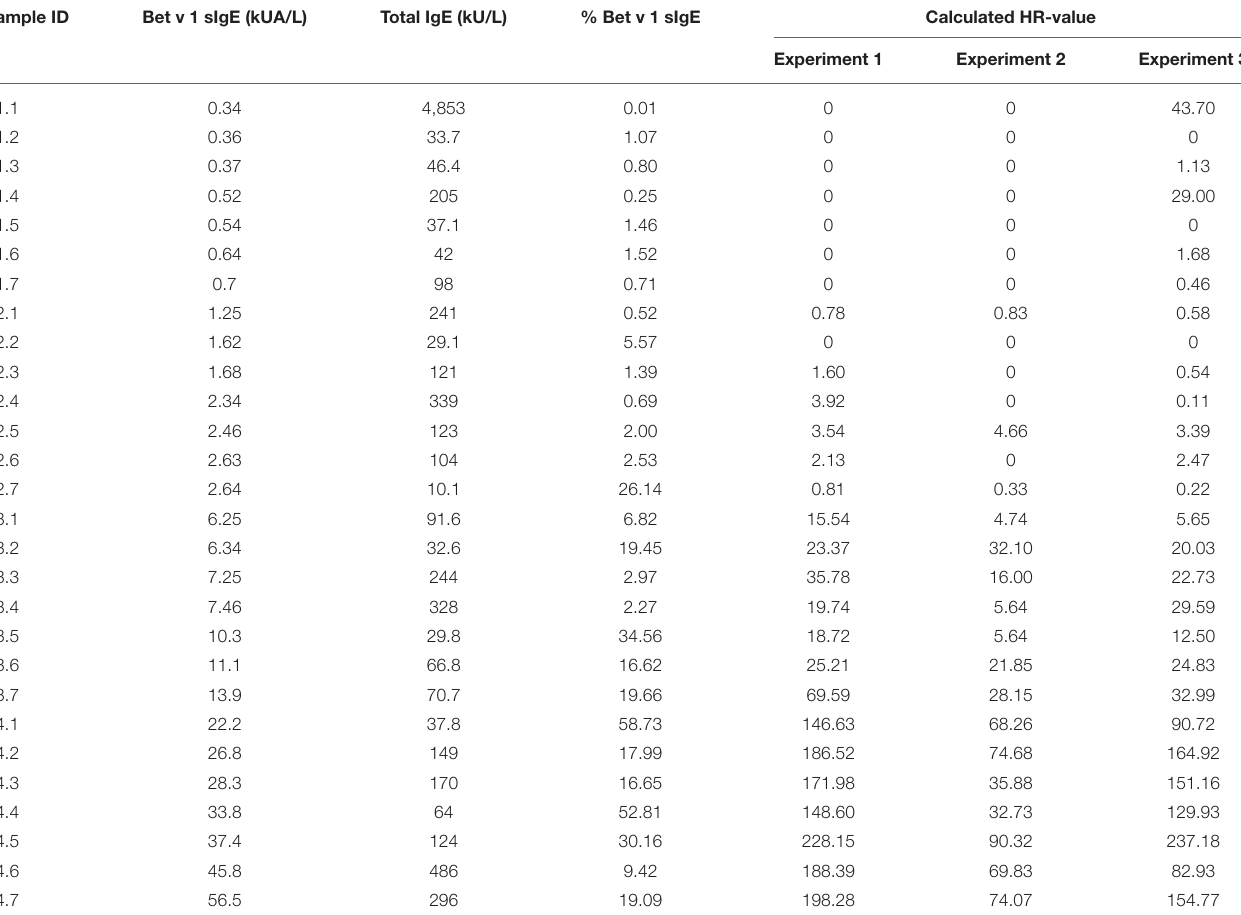
TABLE 1 | Concentrations of Bet v 1 sIgE, total IgE, and % Bet v 1 sIgE in the 28 serum samples and the histamine release (HR) value obtained from the 3 runs of passive HR. Sample